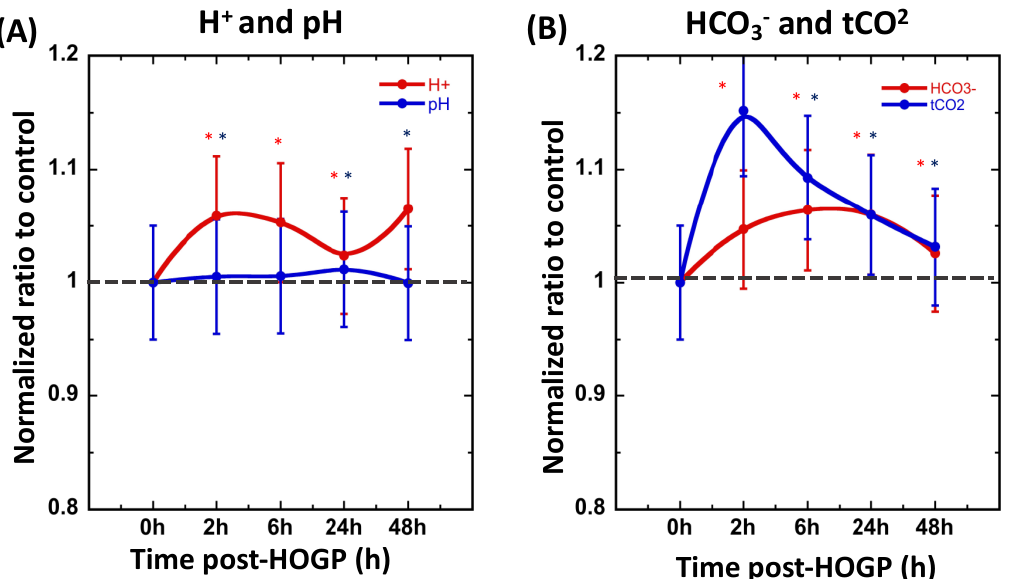
Figure 4. Time course of the blood levels of hydrogen, pH, bicarbonate (HCO 3 − ), and total carbon dioxide (tCO 2 ) post-application of the HOGP. Normalized ratios of H + and pH ( A ), and HCO 3 and tCO 2 ( B ). The normalized ratios ( y -axis) were determined by normalization to the control group. Significant differences were identified using t -tests (* p < 0.05).